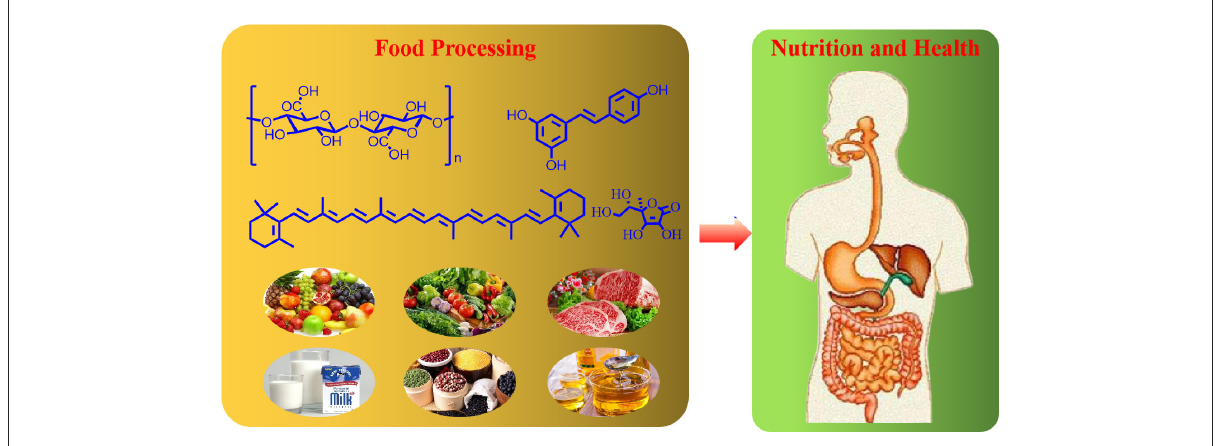
FIGURE1 Food processing affecting food components and their health